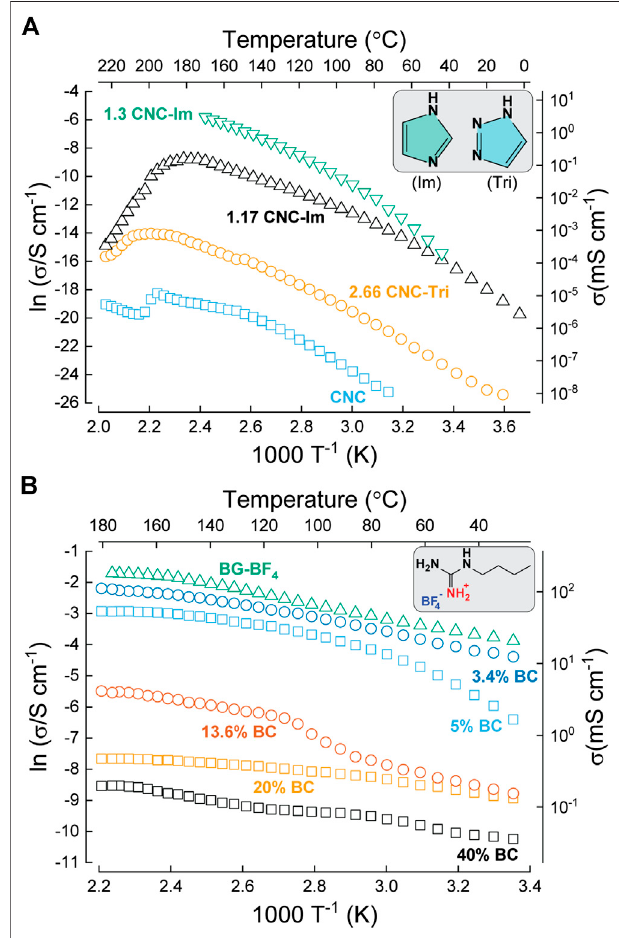
FIGURE 14 | Temperature-dependent proton conductivity in anhydrous conditions. (A) CNC blended with imidazole and 1H-1,2,3-triazole (structures shown inset). Redrawn from Tritt-Goc et al. (2019). Tritt-Goc et al. (2020). (B) Bacterial cellulose impregnated with the protic ionic liquid N-butylguanidinium tetra fl uoroborate (BG-BF4, structure shown inset). Redrawn from Rogalsky et al.